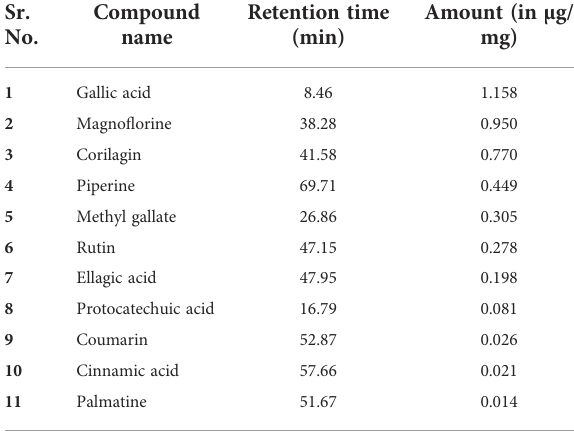
TABLE 1 Quantitative analysis of phytometabolites in Madhugrit.